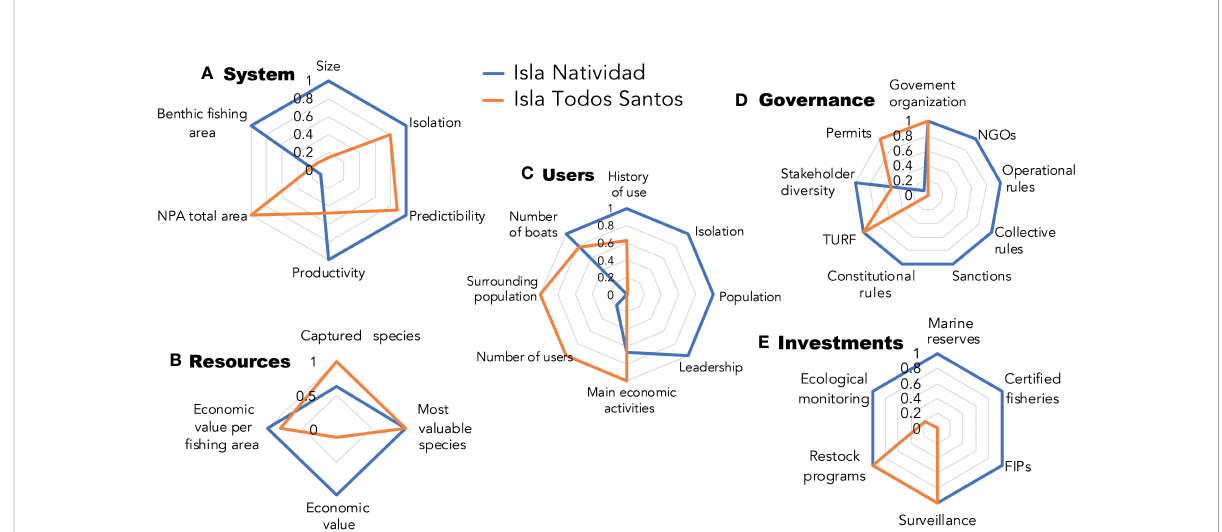
FIGURE 3 Comparison of the social-ecological characteristics of Isla Natividad (IN) and Isla Todos Santos (ITS) SESs (Social Ecological Systems) using standardized values ranging from 0 to 1 (see: Table 1). NPA, Natural Protected Area; FIPs, Fishery Improvement Projects; TURF, Territorial Use Rights for